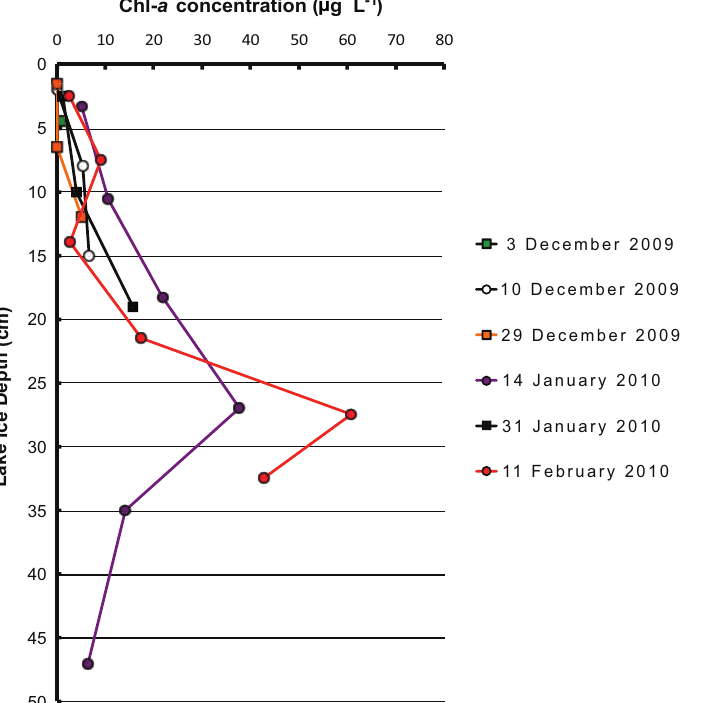
Figure 2. Chl- a distribution in Miquelon Lake ice on six sampling dates throughout the 2009 (cid:177) 2010 winter season: 3 December 2009, 10 December 2009, 29 December 2009, 14 January 2010, 31 January 2010, and 11 February 2010. Depths indicated are the midpoint of ice core segment processed for biological